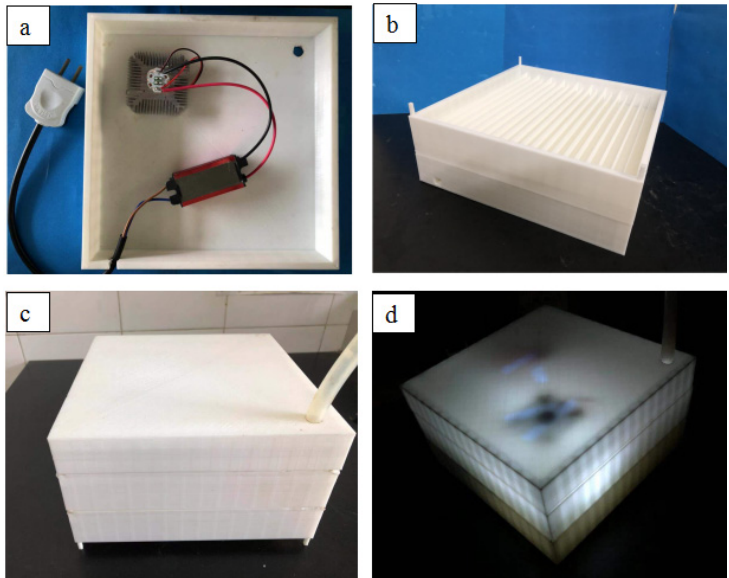
Figure 10. Water treatment equipment diagram: ( a ) UV light source of water treatment equipment; ( b ) photocatalytic unit; ( c ) overall picture of water treatment equipment; ( d ) water treatment equipment operation diagram.